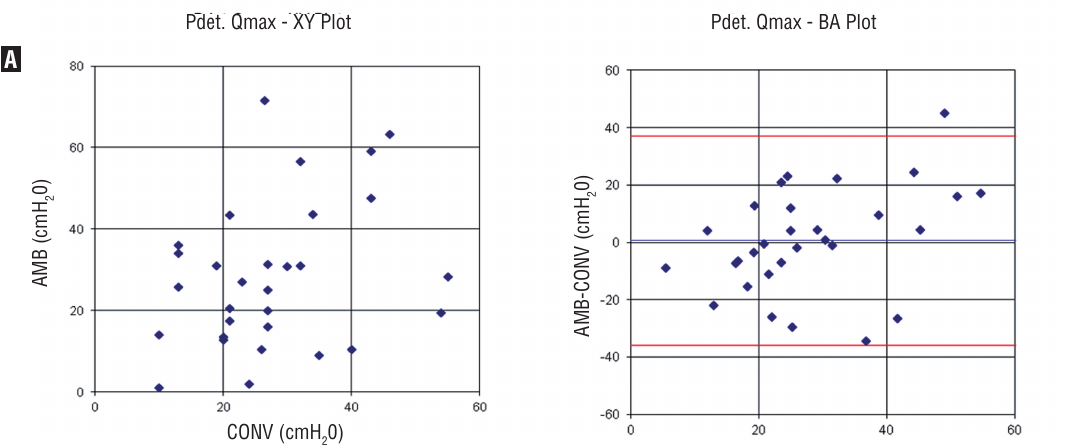
figure 1 - Simple plot of the results of conventional cystometry (CONV) against ambulatory urodynamic monitoring (AMB) and plot of the difference between the methods against their mean